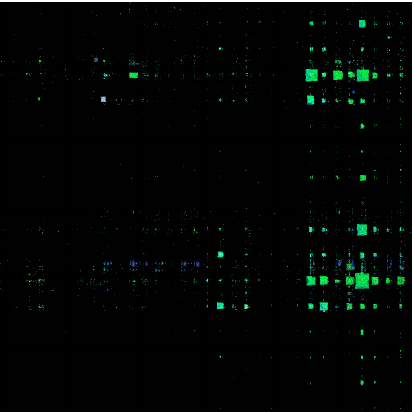
Figure 5. Examples of image features for mobile malicious sample.